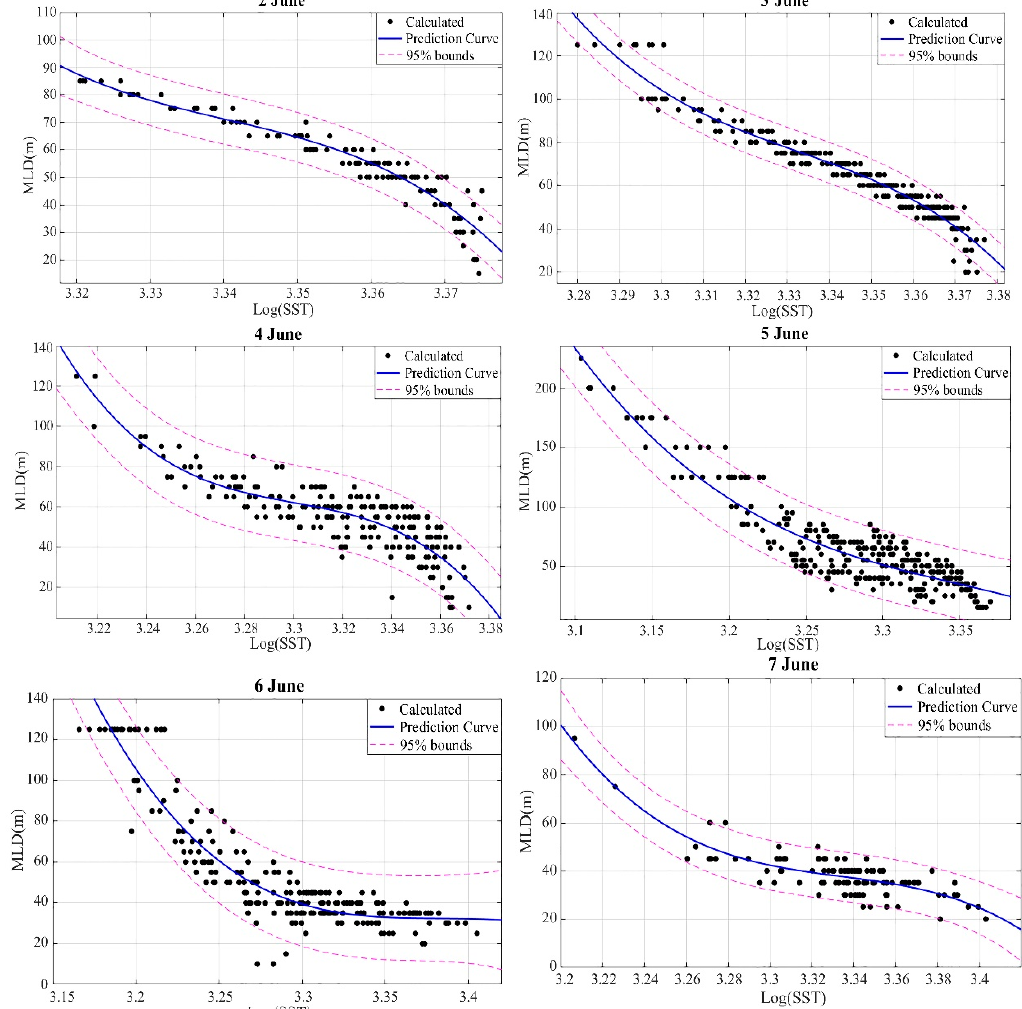
Figure 7. Fitted curves for each date with only the locations with DOI < 200 km.